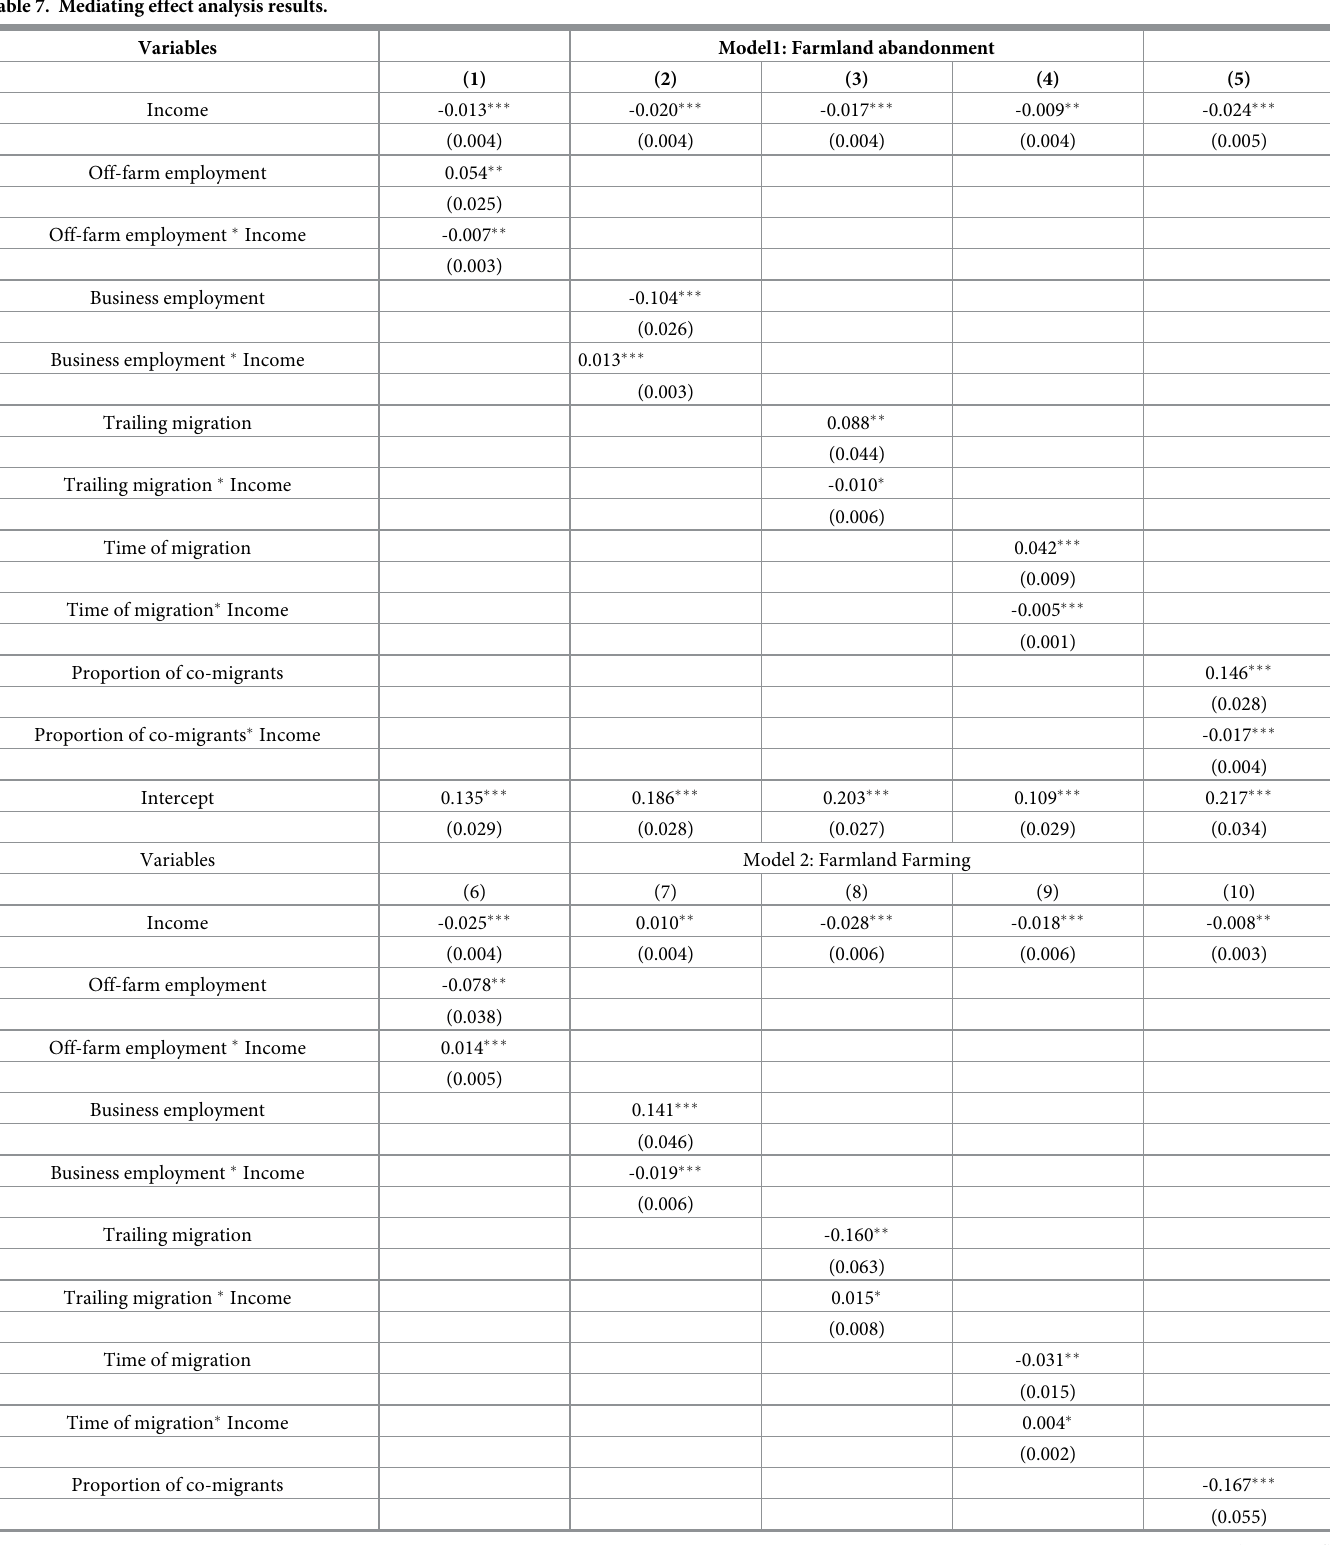
Table 7. Mediating effect analysis